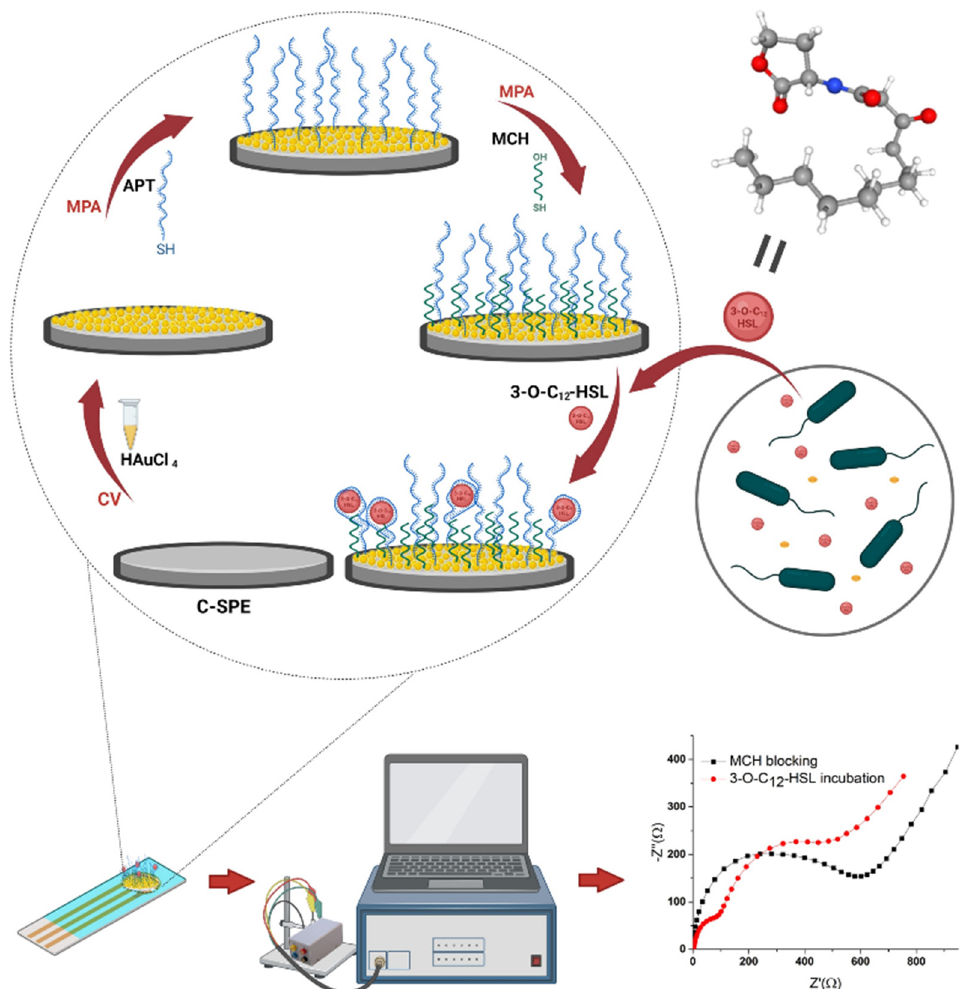
Figure 1. The schematic representation of the proposed aptasensor. Created with BioRender.com (accessed on 11 May 2022).